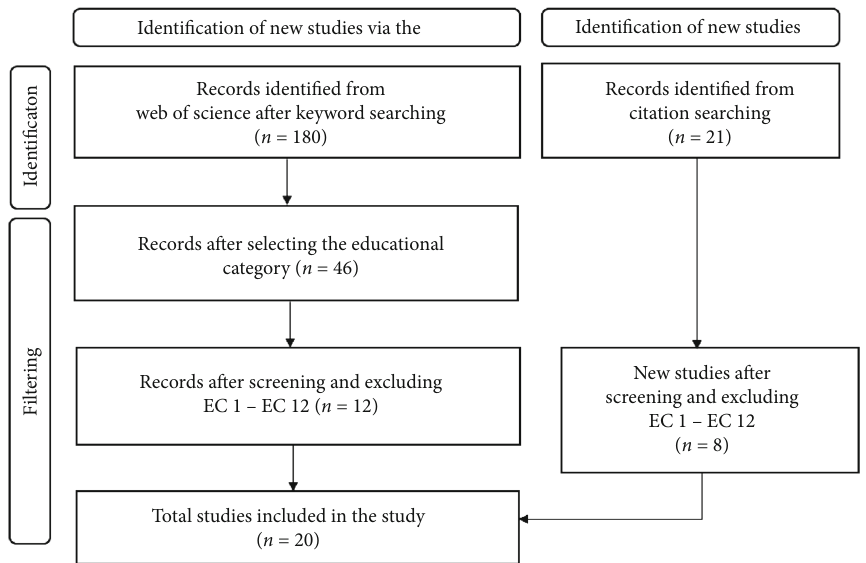
Figure 1: The fl ow of literature